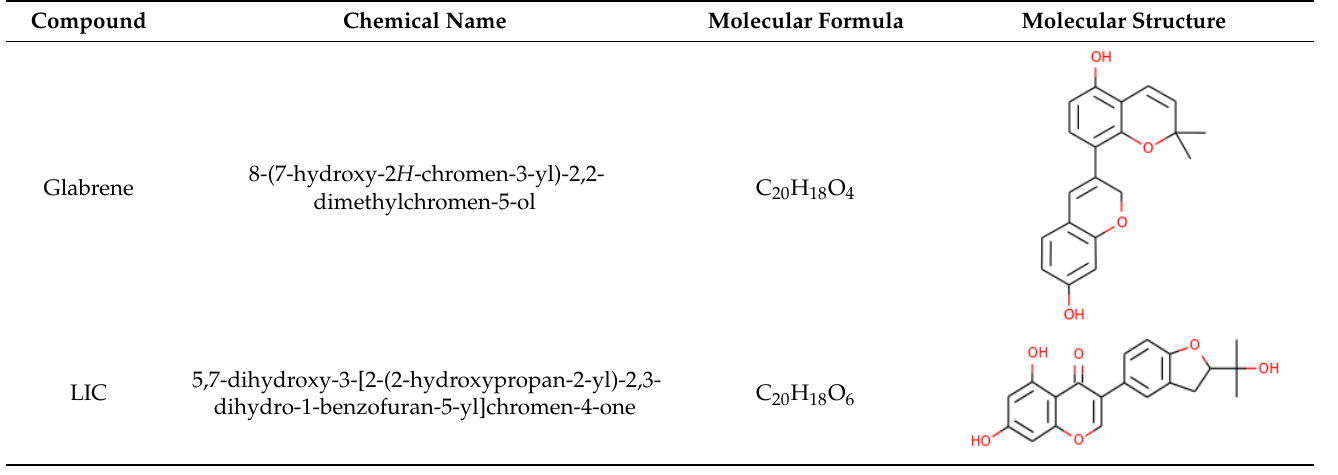
Figure 2. Representation of the 2D interaction showing YES1 interactions with ( A ) Glabrene, ( B ) LIC, and ( C ) Dasatinib. Table 4. The chemical properties of the elucidated compounds.